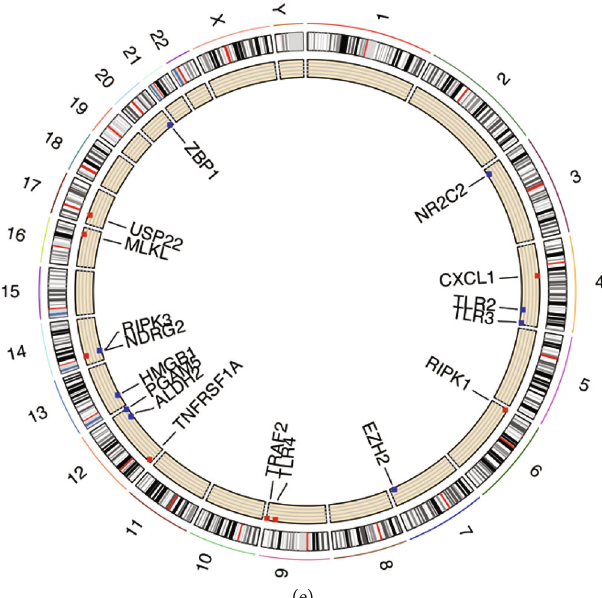
Figure 1: Expression and genetic variation landscape of necroptosis-related genes in LUAD. (a) The mRNA level of 17 necroptosis-related genes in LUAD. (b), and (c) The mutation frequency and classi fi cation of 17 necroptosis-related genes in LUAD. (d) The CNV frequency of 17 necroptosis-related genes in LUAD. The height of the column represented the alteration frequency. (e) The location on chromosomes of CNV of 17 necroptosis-related genes. ** P < 0 : 01 , *** P < 0 : 001